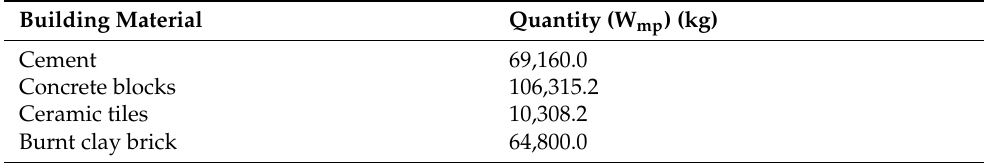
Table 1. Quantities of